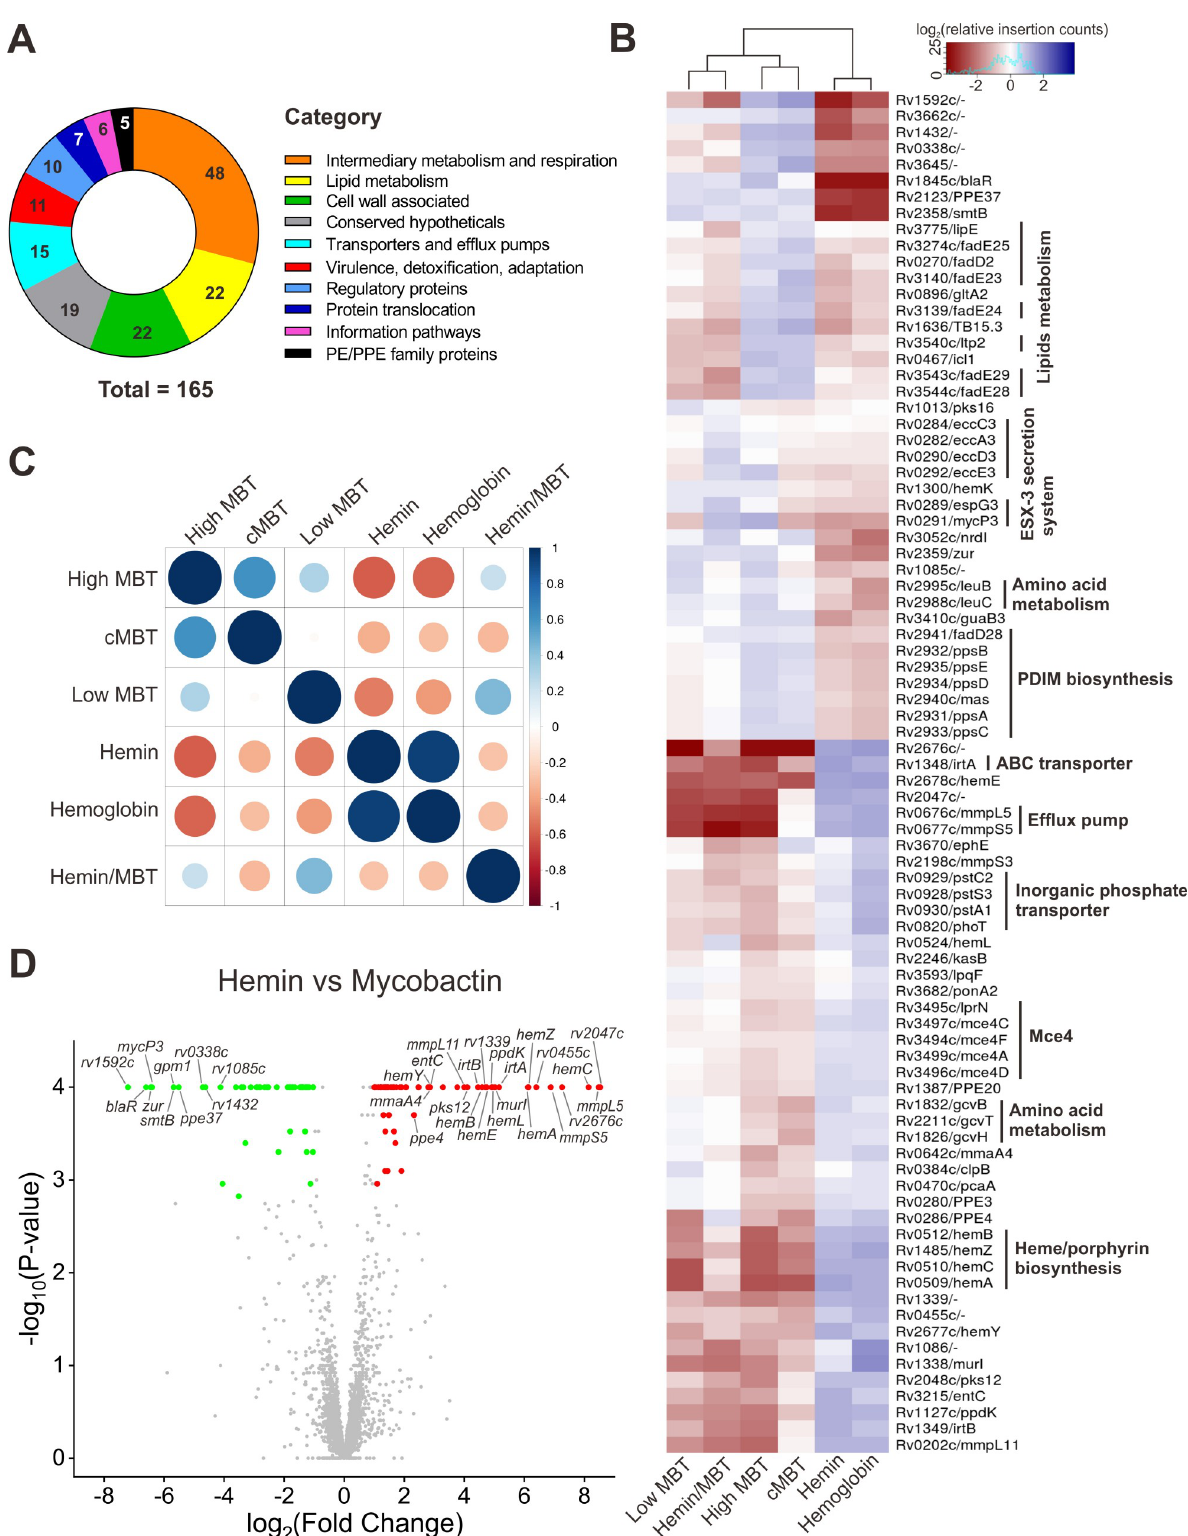
Fig 3. TnSeq analysis of the M . tuberculosis transposon libraries. A subset of 165 varying genes were identified by ANOVA. The mean normalized insertion count is calculated for each gene in each of the 6 conditions. Then a log-fold-change is calculated for each condition relative to the mean